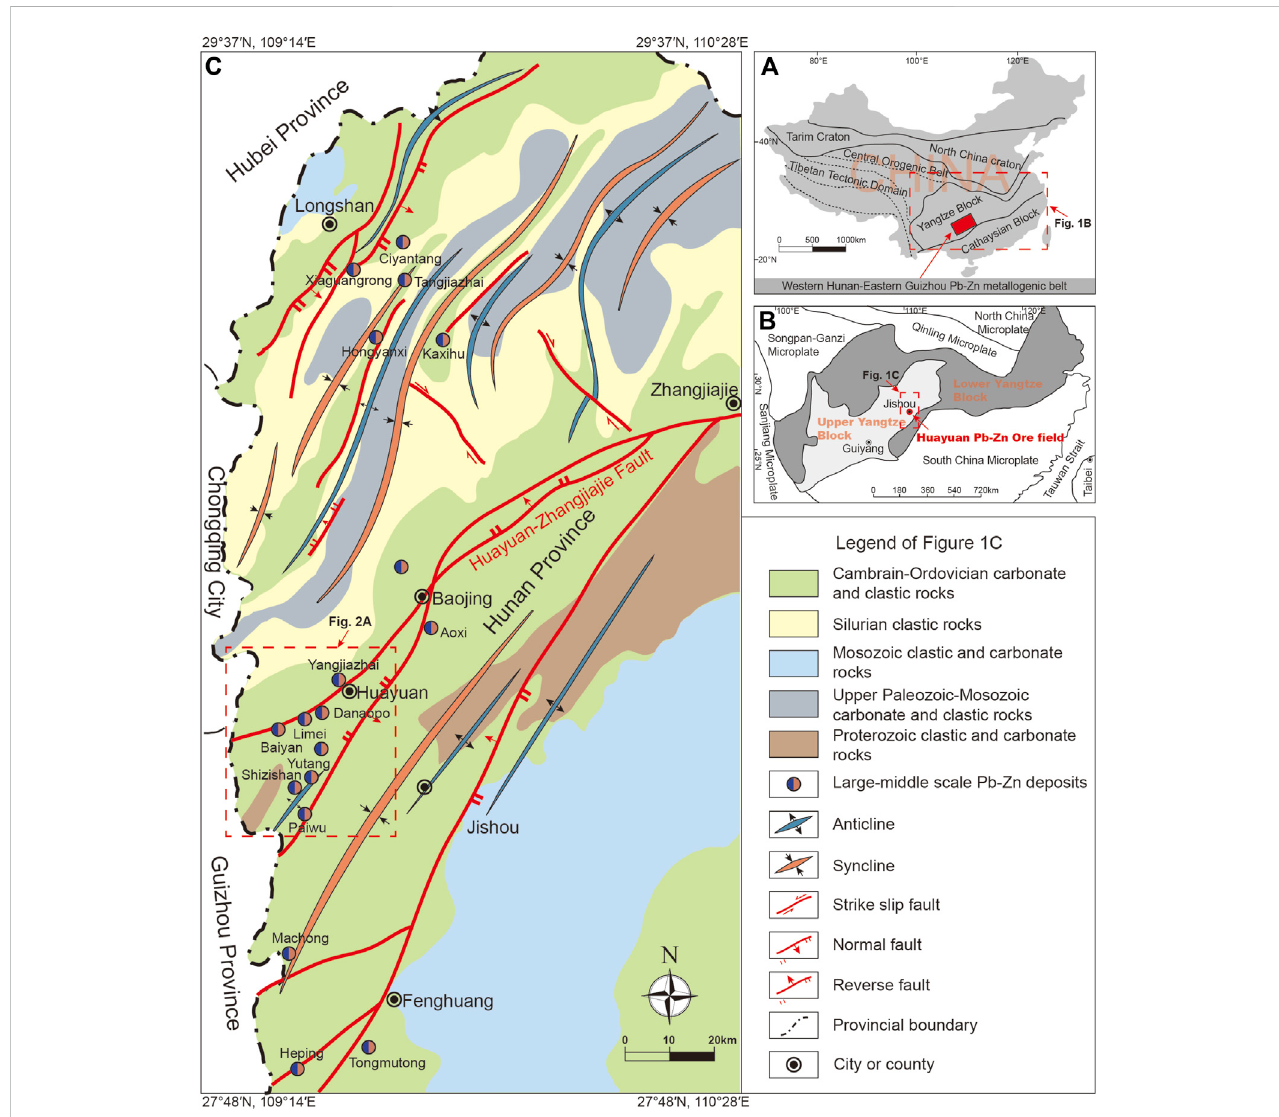
FIGURE 1 (A) Regional tectonic map of the western Hunan-eastern Guizhou Pb-Zn metallogenic belt (modi fi ed after Zhou et al., 2013; Wu et al., 2021); (B) Geotectonic map of the Huayuan Pb-Zn ore fi eld in the Upper Yangtze Block (modi fi ed after Wu et al., 2021). (C) Geologic map of the Western Hunan Pb-Zn metallogenic belt in South China (modi fi ed after Wu et al., 2021; Yang and Lao, 2007) showing the distribution of Pb-Zn deposits, structures, and